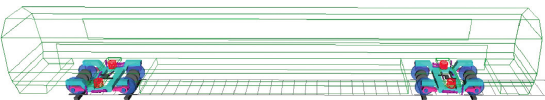
Figure 5: High-speed train simulation